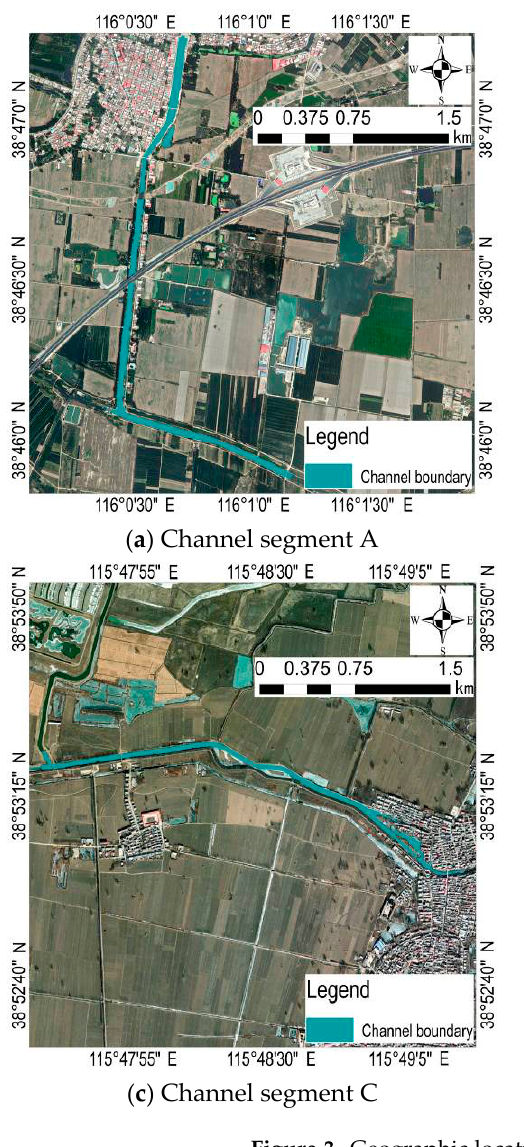
Figure 3. Geographic location and water boundary of the four river sections. ( a ) A water area of 3.48 km in length and 0.21 km 2 in area was obtained, and the perimeter of the water boundary was 15.08 km on 5 November 2022; ( b ) B water area with a length of 2.05 km and an area of 0.05 km 2 was obtained, and the perimeter of the water boundary was 4.62 km on 20 December 2022; ( c ) C water area with a length of 3.12 km and an area of 0.13 km 2 was obtained, and the perimeter of the water boundary was 9.08 km on 17 January 2023; ( d ) D water area with a length of 1.82 km and an area of 0.19 km 2 was obtained, and the perimeter of the water area boundary was 3.66 km on 24 February 2023.